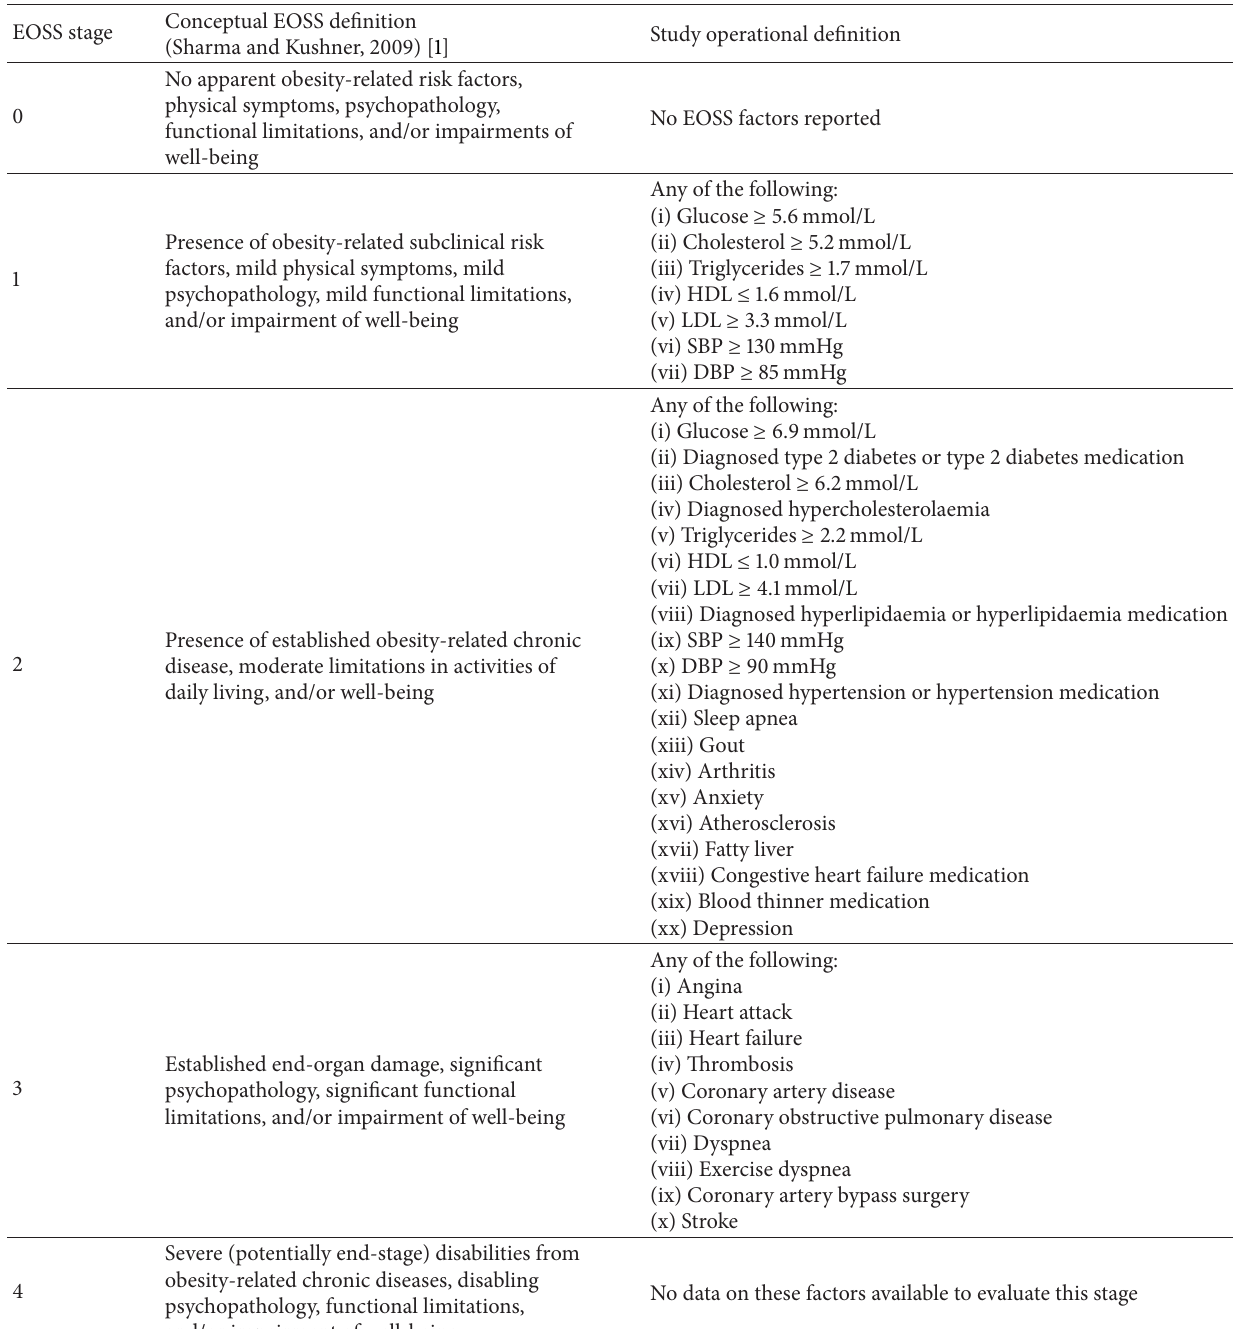
Table 1: Edmonton Obesity Staging System (EOSS) study operational